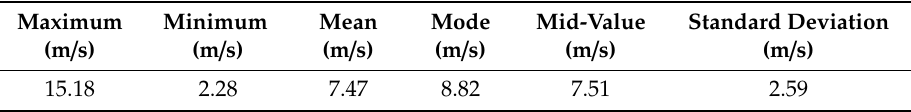
Table 5. Wind speed statistics data.